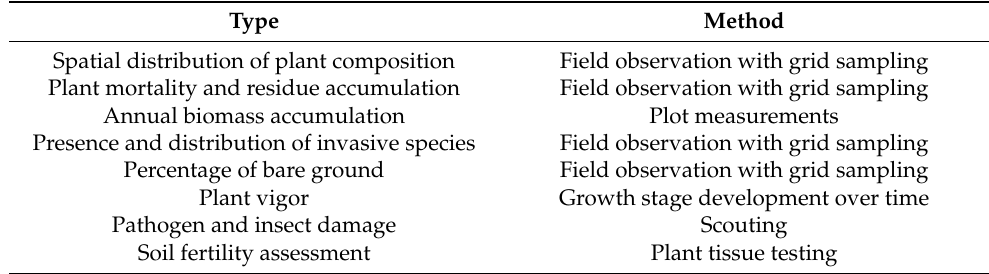
Table 2. Grassland attributes to be measured when assessing grazing influence of soil